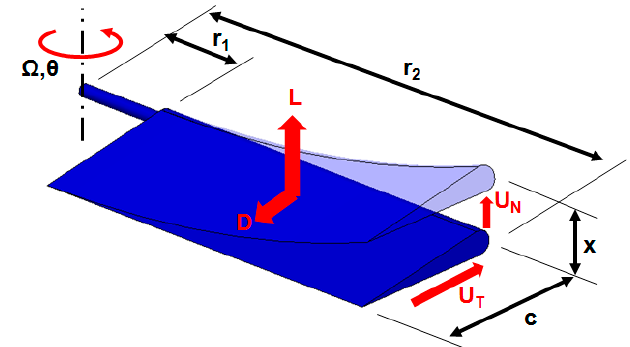
Figure 4. Definition of parameters and directions.